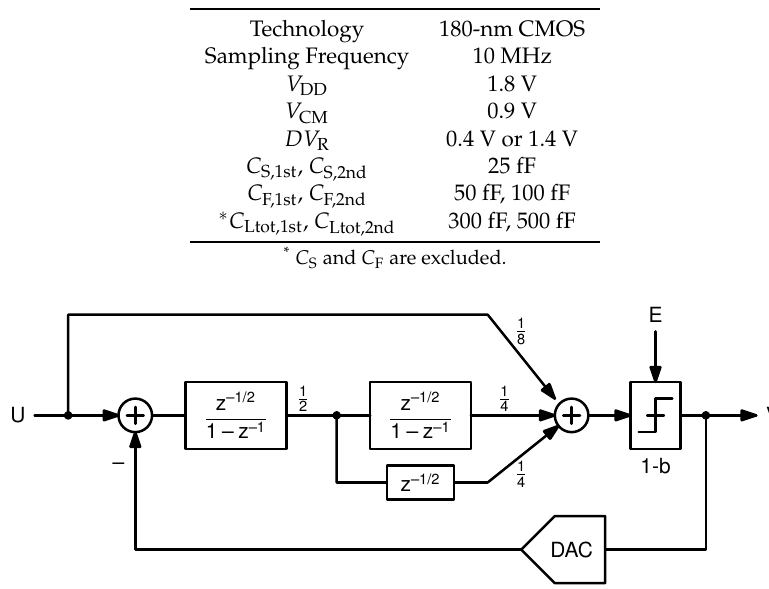
Table 1. Summary of design.